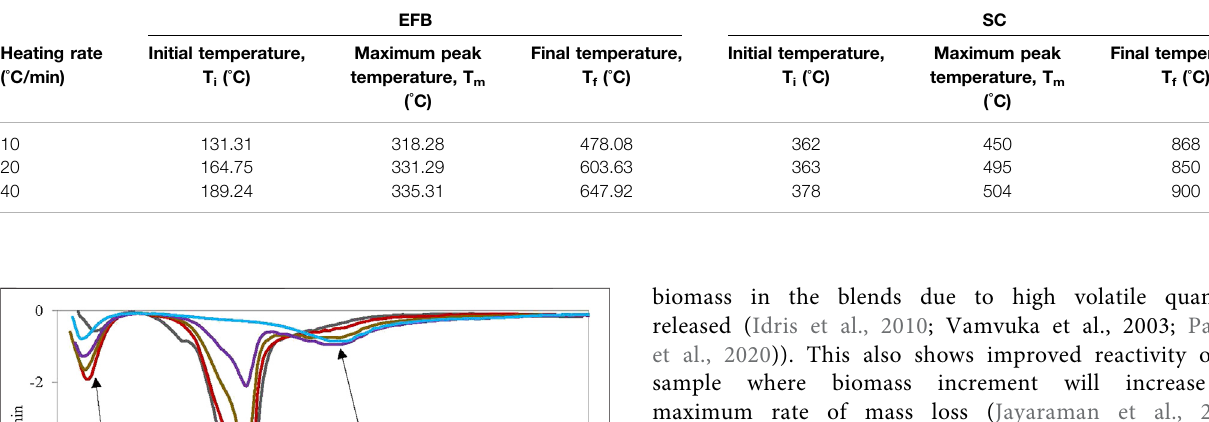
TABLE 2 | The characteristic temperatures of EFB and SC pyrolysis at heating rate of 10, 20, and 40 ° C/min.